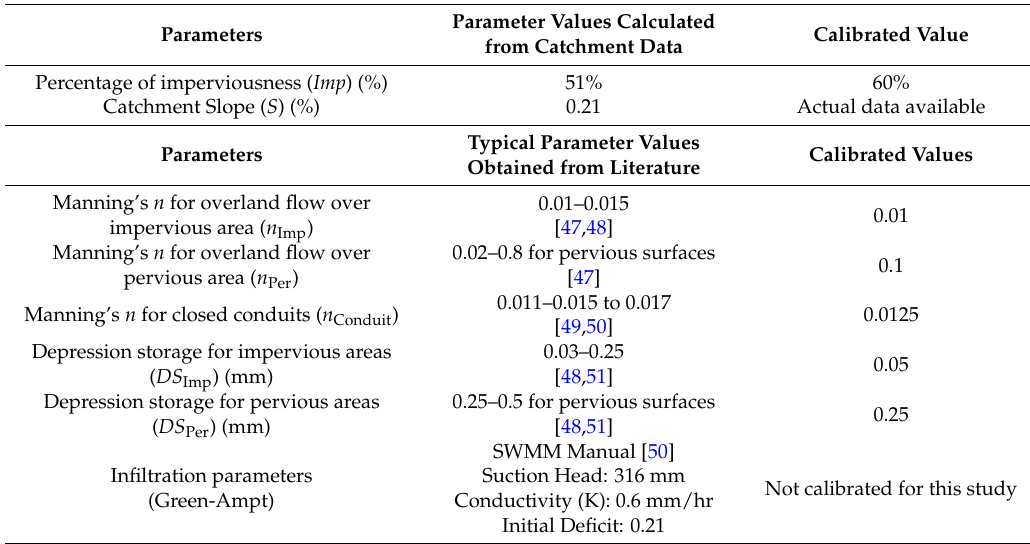
Table 3. Model parameters and their